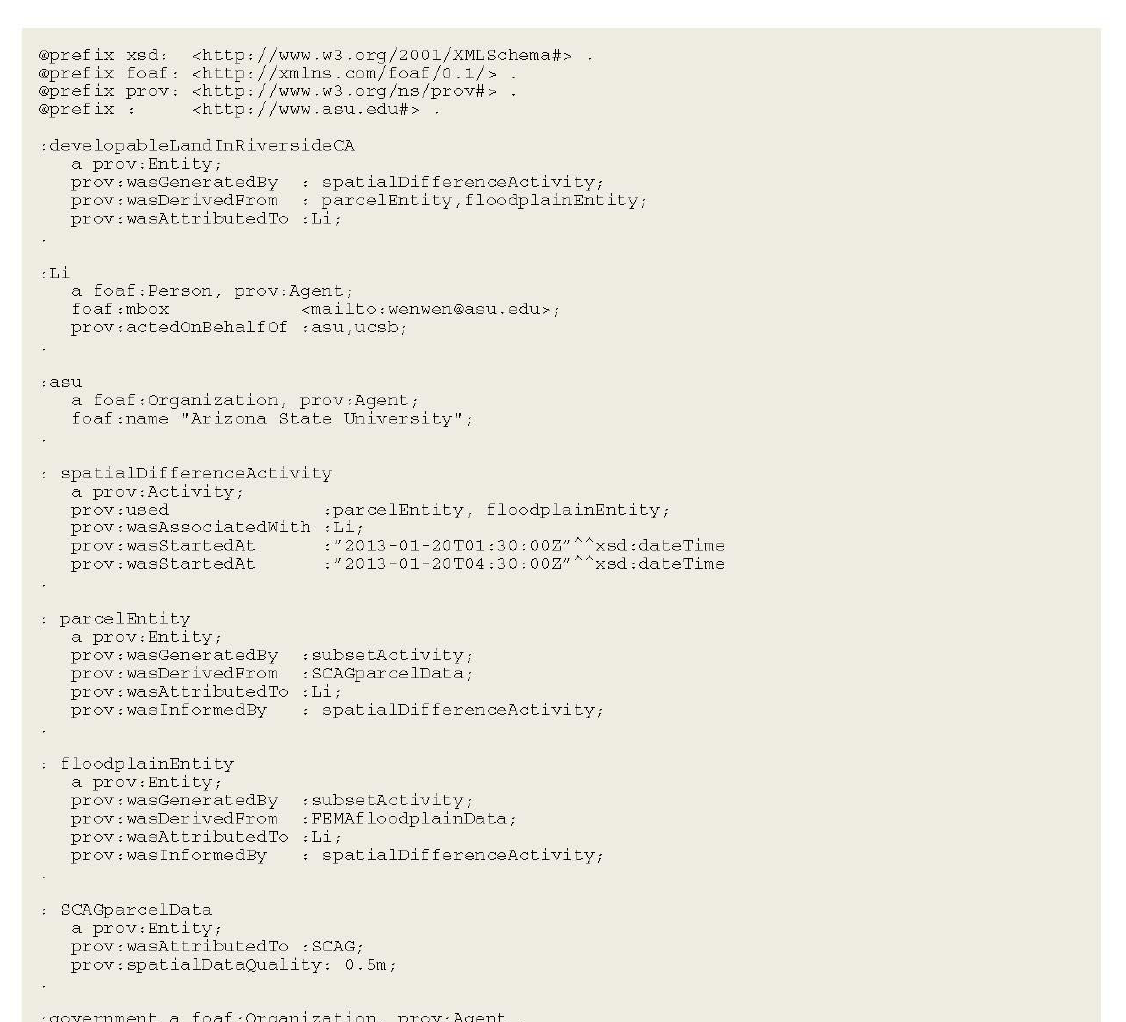
Figure 7. An example PROV ontology tracing the generation of developable land parcels in Riverside